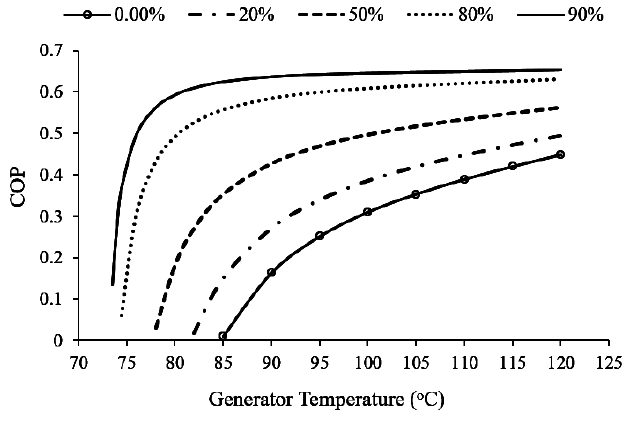
Figure 35. Variations of COPs with different ε SHX at different T gen .